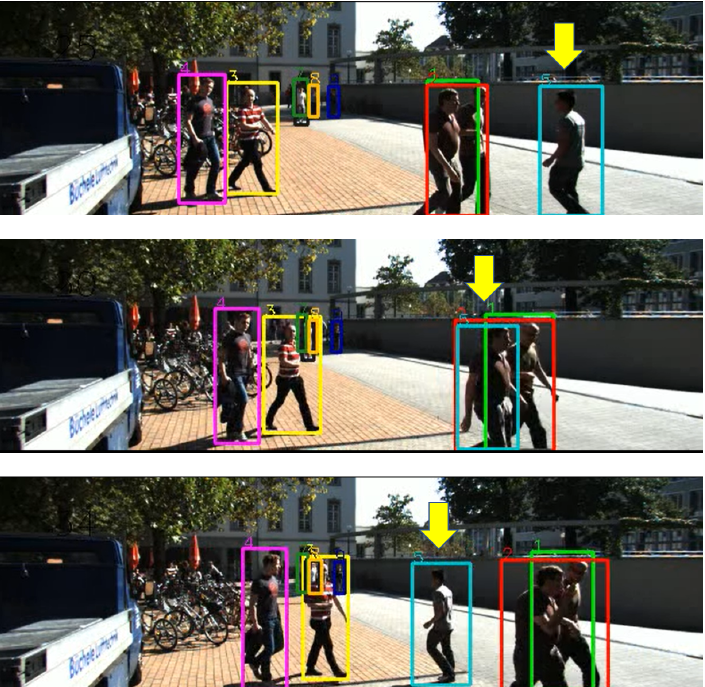
Figure 2. Preserving the ID during full occlusion. The frames are obtained from the MOT15 dataset [19]. The yellow arrow is pointing towards a track ( top image ) that experiences full oc- clusion ( middle image ). The objective of the MOT system is to preserve the ID of the track ( bottom image ) and matches the previously detected object with the reappeared